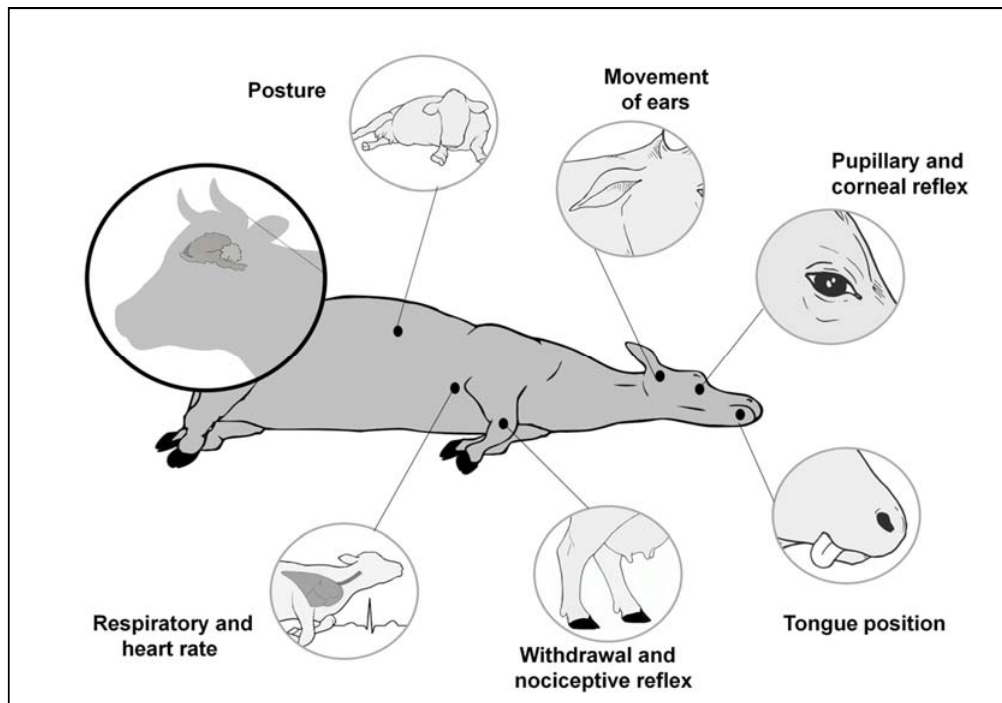
Figure 4. Indicators during slaughter caused by the absence, or poor application, of stunning. Visible indicators include vocalisations, movements of the ears, struggling, bristling, shaking, ocular and pupillary reflexes, the painful withdrawal stimulus, body posture, straightening reflexes, respiratory rhythm, the tongue position and the reflex reaction to a painful stimulus.